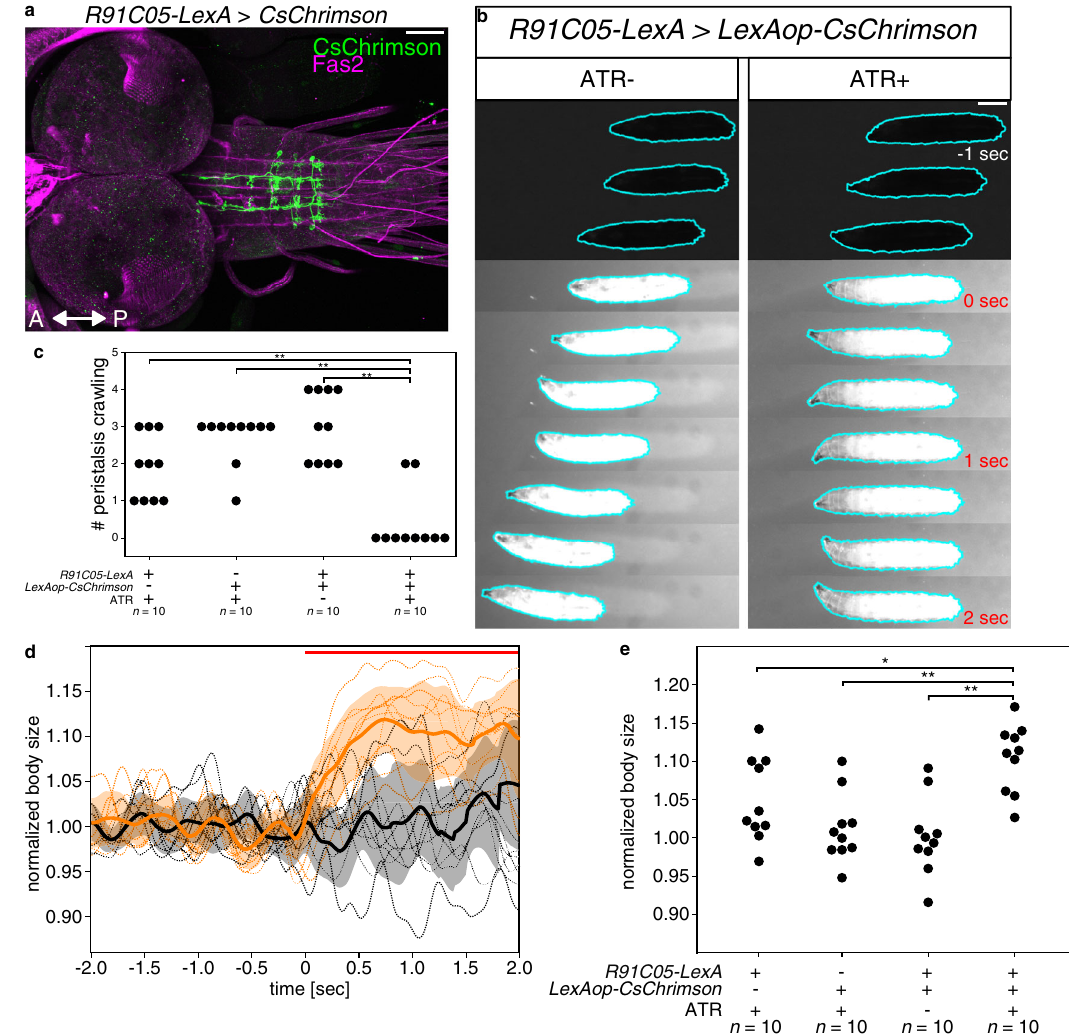
Fig. 2 Activation of Canon neurons induces muscular relaxation. a Expression of CsChrimson driven by R91C05-LexA . Note that the expression is only seen in Canon neurons. b Time-lapse images of control (left, ATR − ) and experimental (right, ATR + ) larvae during optogenetic perturbation. The experimental larva stopped immediately with its body relaxed when exposed to red light. 0 s indicates the onset of light stimulation. Cyan lines indicate contours of the larvae. c Quanti fi cation of the number of forward peristalses during the fi rst 2 s of light stimulation. n = 10 larvae in each group. Eight out of ten larvae in the experimental group halted with their muscles relaxed upon photo-stimulation, while no control larvae stopped locomotion. d Change in the body size of the larvae after photostimulation (orange, experimental; black, control ATR − ). The central thick lines represent mean values. The error bands (shaded area) show standard deviation. Dotted lines indicate values of individual larvae. Red bar shows the duration of photostimulation. e Quanti fi cation of the normalized size of the larvae during the fi rst 2 s of light stimulation. n = 10 larvae in each group. * p < 0.05, ** p < 0.01. Comparison with LexAop − , p = 4.29 × 10 − 3 ; comparison with LexA − , p = 4.29 × 10 − 3 ; comparison with ATR − , p = 4.29 × 10 − 3 , the two-sided Fisher exact test with the Holm method ( c ). Comparison with LexAop − , p = 3.12 × 10 − 2 ; comparison with LexA − , p = 3.41 × 10 − 3 ; comparison with ATR − , p = 3.02 × 10 − 3 , the two-sided Mann – Whitney U -test with the Holm method ( e ). Scale bars, 50 μ m ( a ) and 1 mm ( b